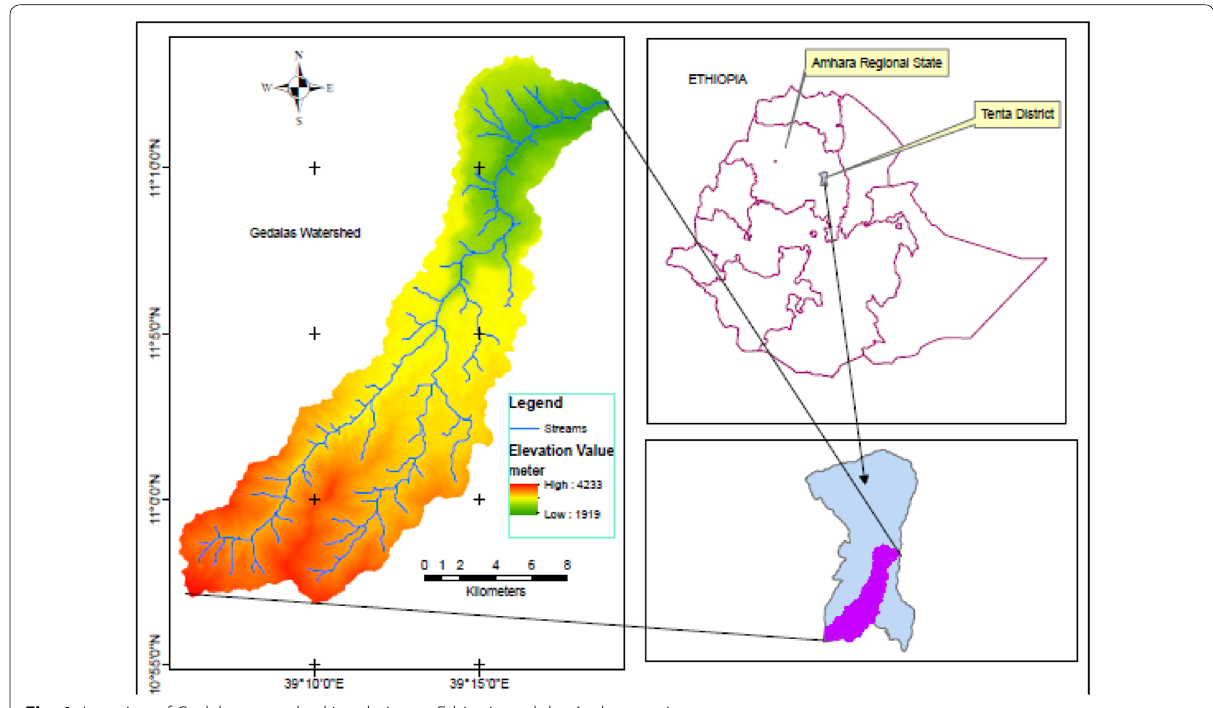
Fig. 1 Location of Gedalas watershed in relation to Ethiopia and the Amhara region